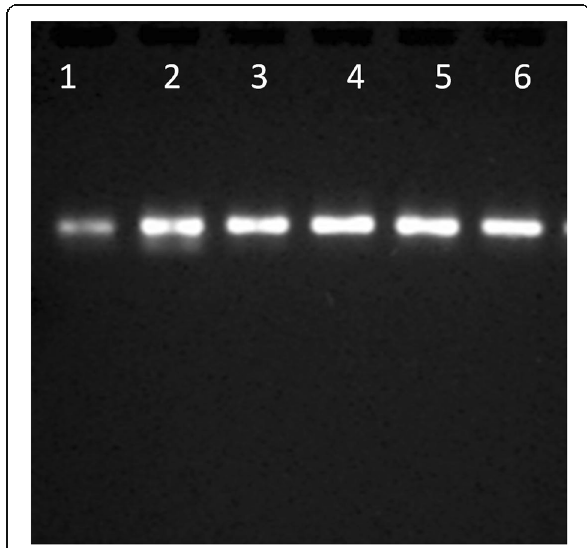
Fig. 3 0.8% Agarose gel image representing the DNA obtained from some of the species labeled in numerical order. Intact mt-DNA band was obtained for the Coleopteran species and was further processed for PCR reaction